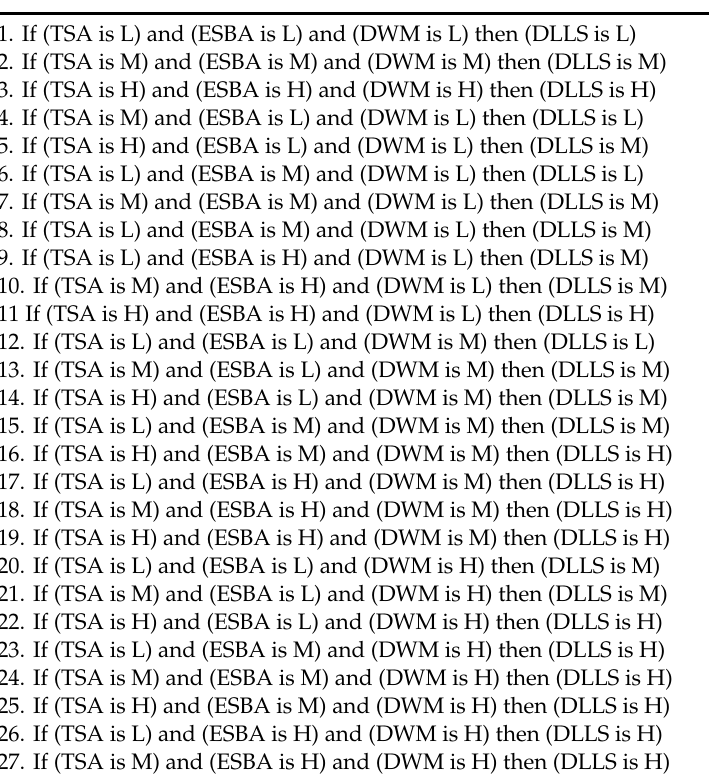
Table 2. Rules defined for the FIS sub-model used to estimate Life Lines Sources Damage (LLSD). Water Mains; Antecedent’s and consequent’s membership functions: H = high, M = medium, L =